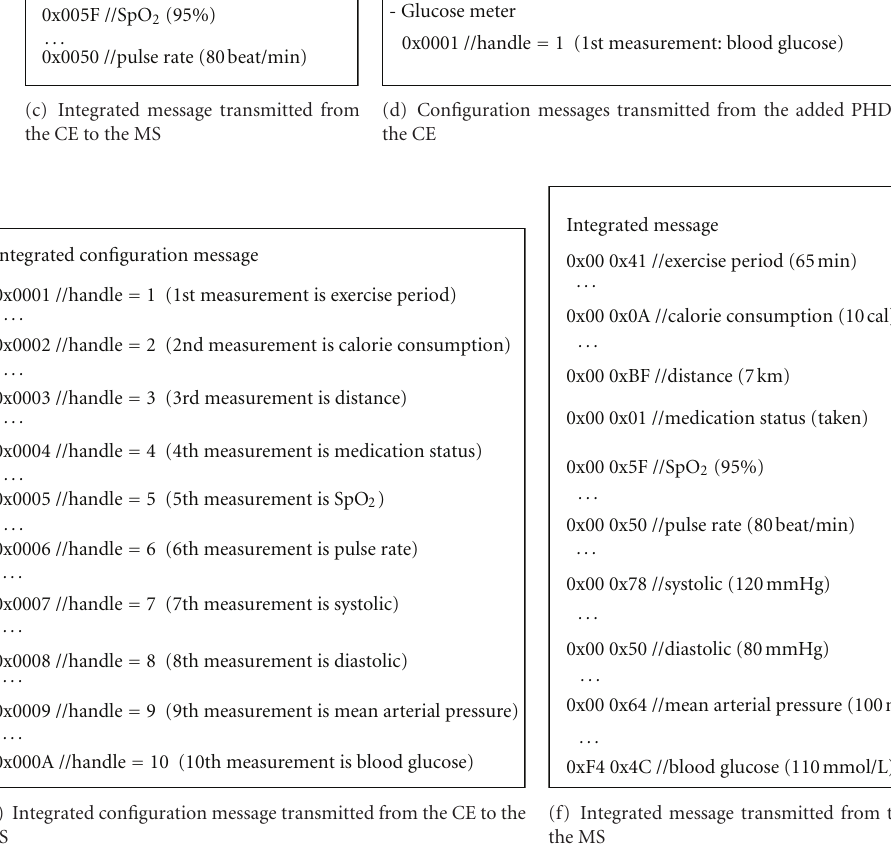
Figure 4: Message integration